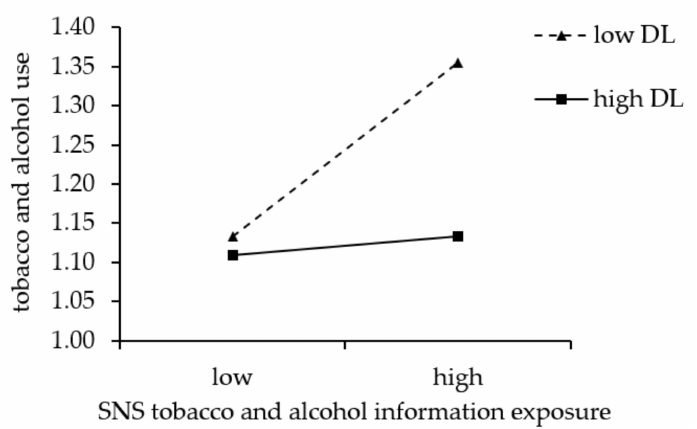
Figure 2. Moderating effect of digital literacy (DL) on the relationship between SNS tobacco and alcohol information exposure and tobacco and alcohol